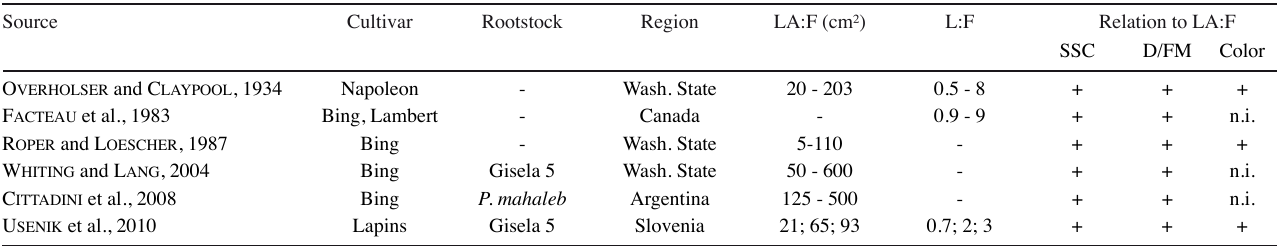
Tab. 4: Summary of studies on the relation between leaf area (LA)/ leaf number (L) per fruit (F) on soluble solids content (SSC), diameter (D), fresh mass (FM) and coloration of sweet cherry